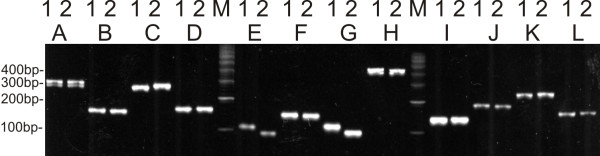
PCR amplification patterns of EST-derived microsatellites of Physcomitrella patens in two accessions. Exemplary SSR marker A – L were amplified in two Physcomitrella patens accessions, the standard lab strain 'Gransden' (1) and 'Villersexel-K3' (2) originating from England and France, respectively. The SSR marker A shows a double banding. The SSRs A, B, D, F and I reveal no visible size polymorphism between the two accessions. The SSRs C, E and G reveal distinct visible single size polymorphisms between the two accessions. The SSRs J, K and L show possible small size polymorphisms between the two accessions which have to be further confirmed. The SSR marker H shows an unexpected size shift, most likely due to an intron. DNA size markers (M) is a 100 bp ladder (SIGMA-Aldrich).